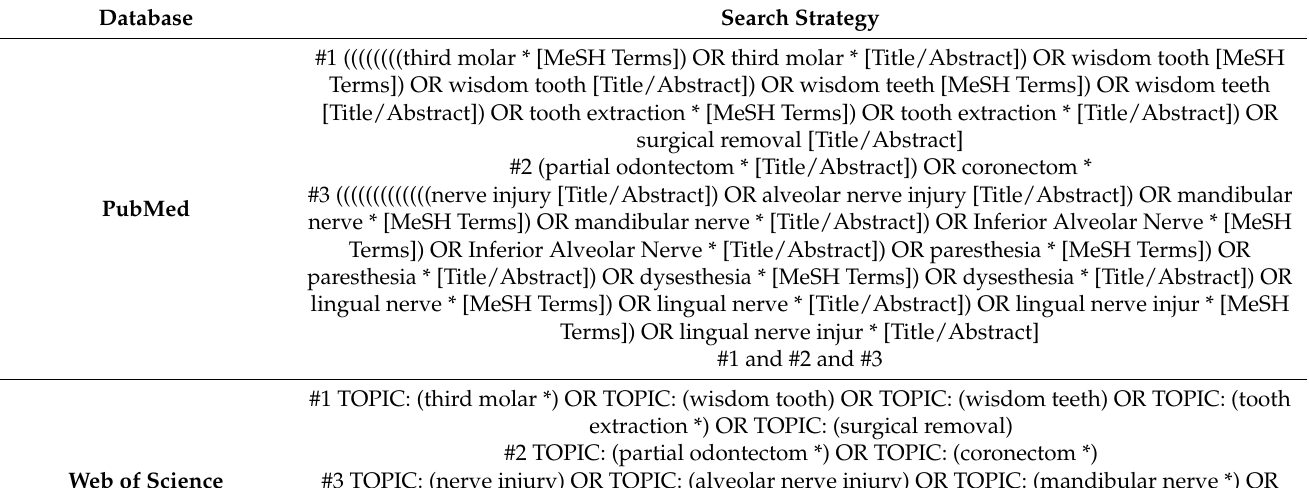
Table 1. The electronic database used and search strategy. Search